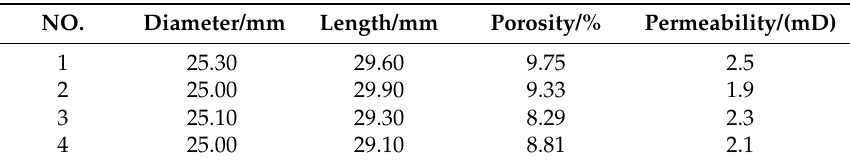
Table 1. Characters of the original rock samples.